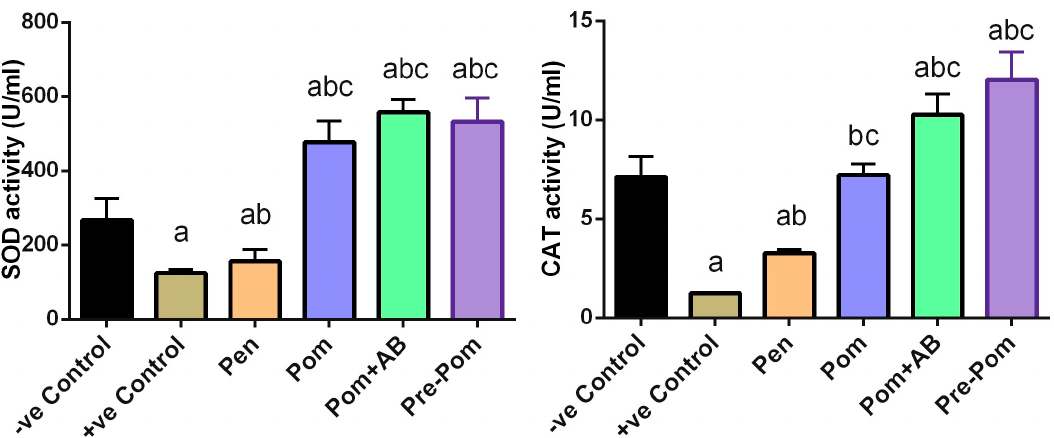
Figure 6. Effect of pomegranate juice supplementation and Pentostam treatment on dermal antioxidant enzyme activities in the control and experimental groups at four weeks after infection. Values are mean ± SEM (n = 10). a p < 0.05, significant change compared to –ve Control group; b p < 0.05, significant change compared to +ve Control group; c p < 0.05, significant change compared to Pentostam group. SOD: superoxide dismutase and CAT: catalase.